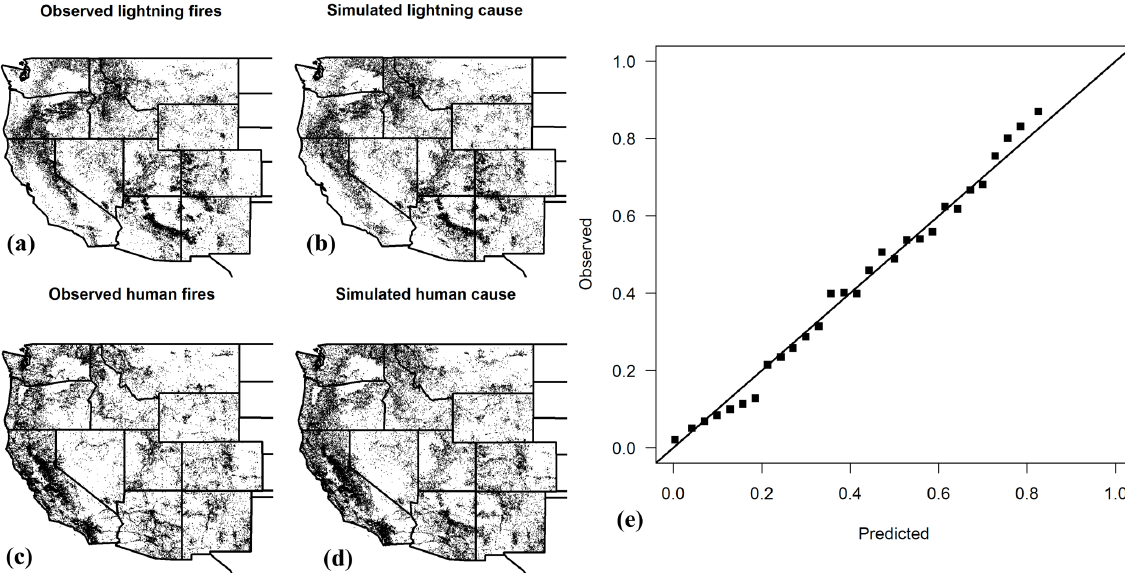
Figure A1. Maps show the locations of observed lightning- (a) and human- (c) caused fires from a simulation which assigned a cause to each simulated ignition from our model ( b and d ). Notice in southern California in the observed human ignitions we see two lines of ignitions in the southeastern part (c) . These are the main highways to Arizona and all fires at these locations are human caused, indicating a correct assignment of simulated ignition cause (d) . Panel (e) shows the observed relative frequency of naturally caused fires plotted against predicted probabilities, after binning the data into 29 classes according to the predicted values.